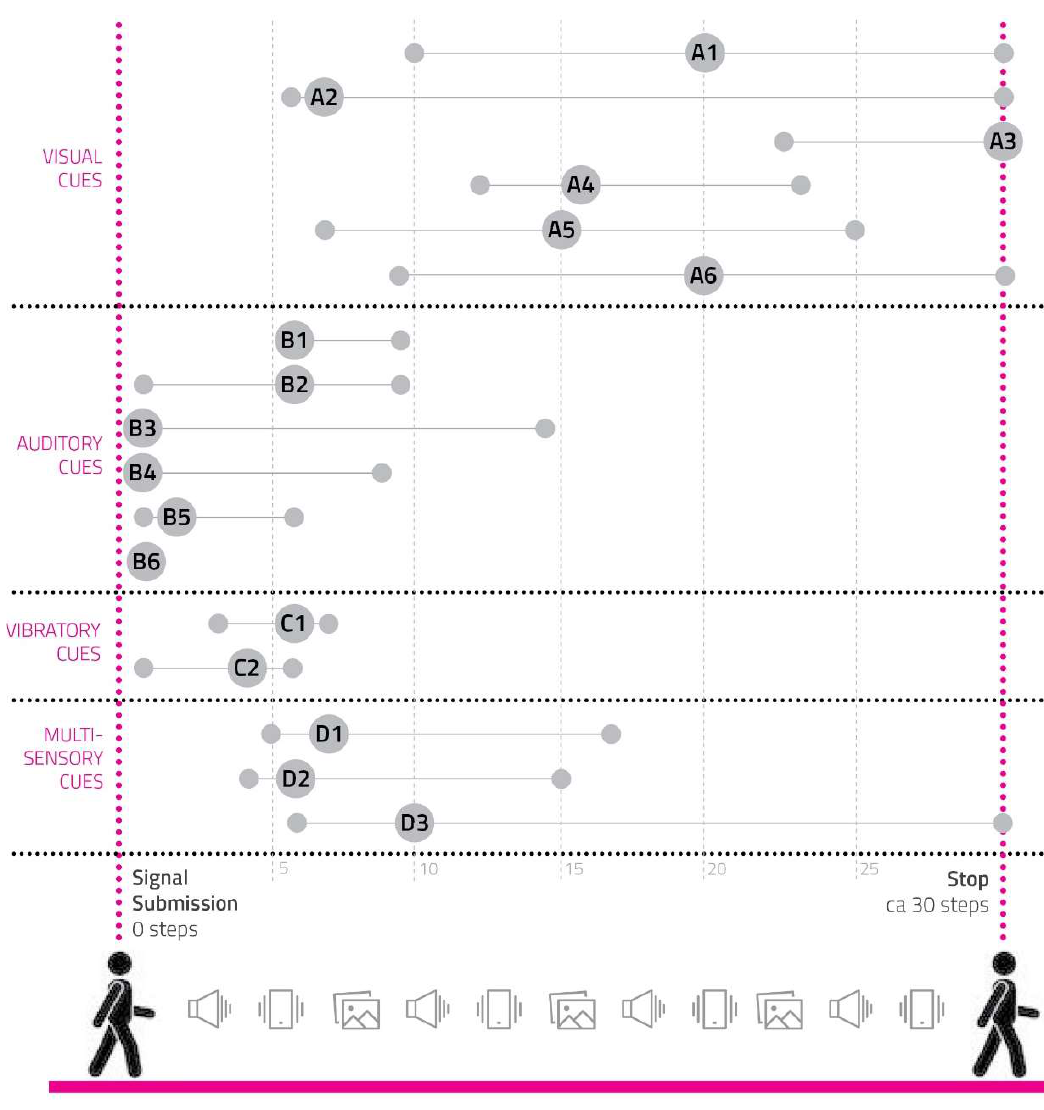
Figure 5. A man silhouette is represented while walking for thirty steps. The different categories of sensory cues are listed on the left, each one including several prototypes of sensory. Every cue prototype corresponds to a line connecting three circles: the first one on the left represents the user reaching the target cadence with the lowest number of steps; the second circle is bigger and shows the cue code, standing for the average number of steps users needed to reach the cadence; the last small circle on the right indicates the user needing the highest number of steps to reach the suggested cadence.